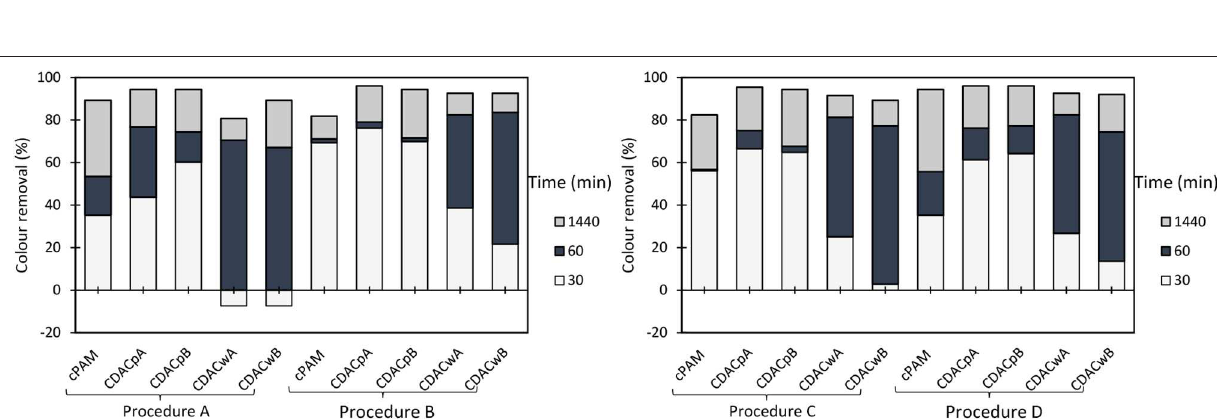
Frontiers in Chemistry |